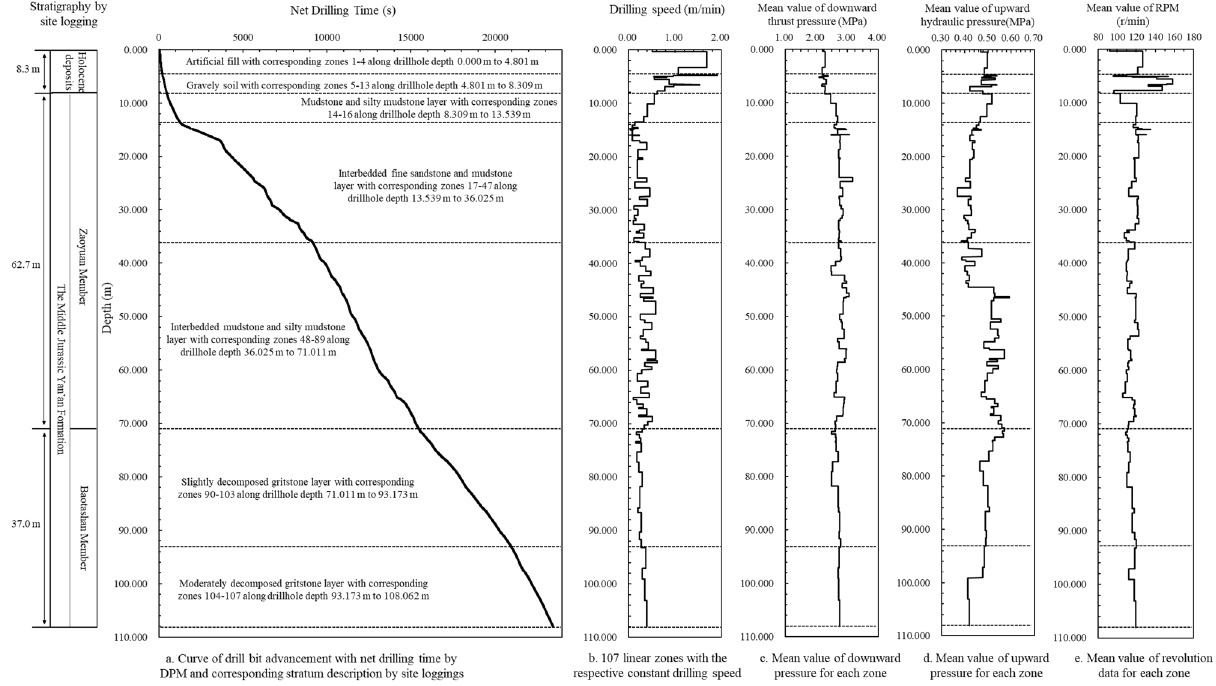
Figure 4. The curve of drill bit advancement with net drilling time and associated drilling parameters along the whole drilling depth by factual